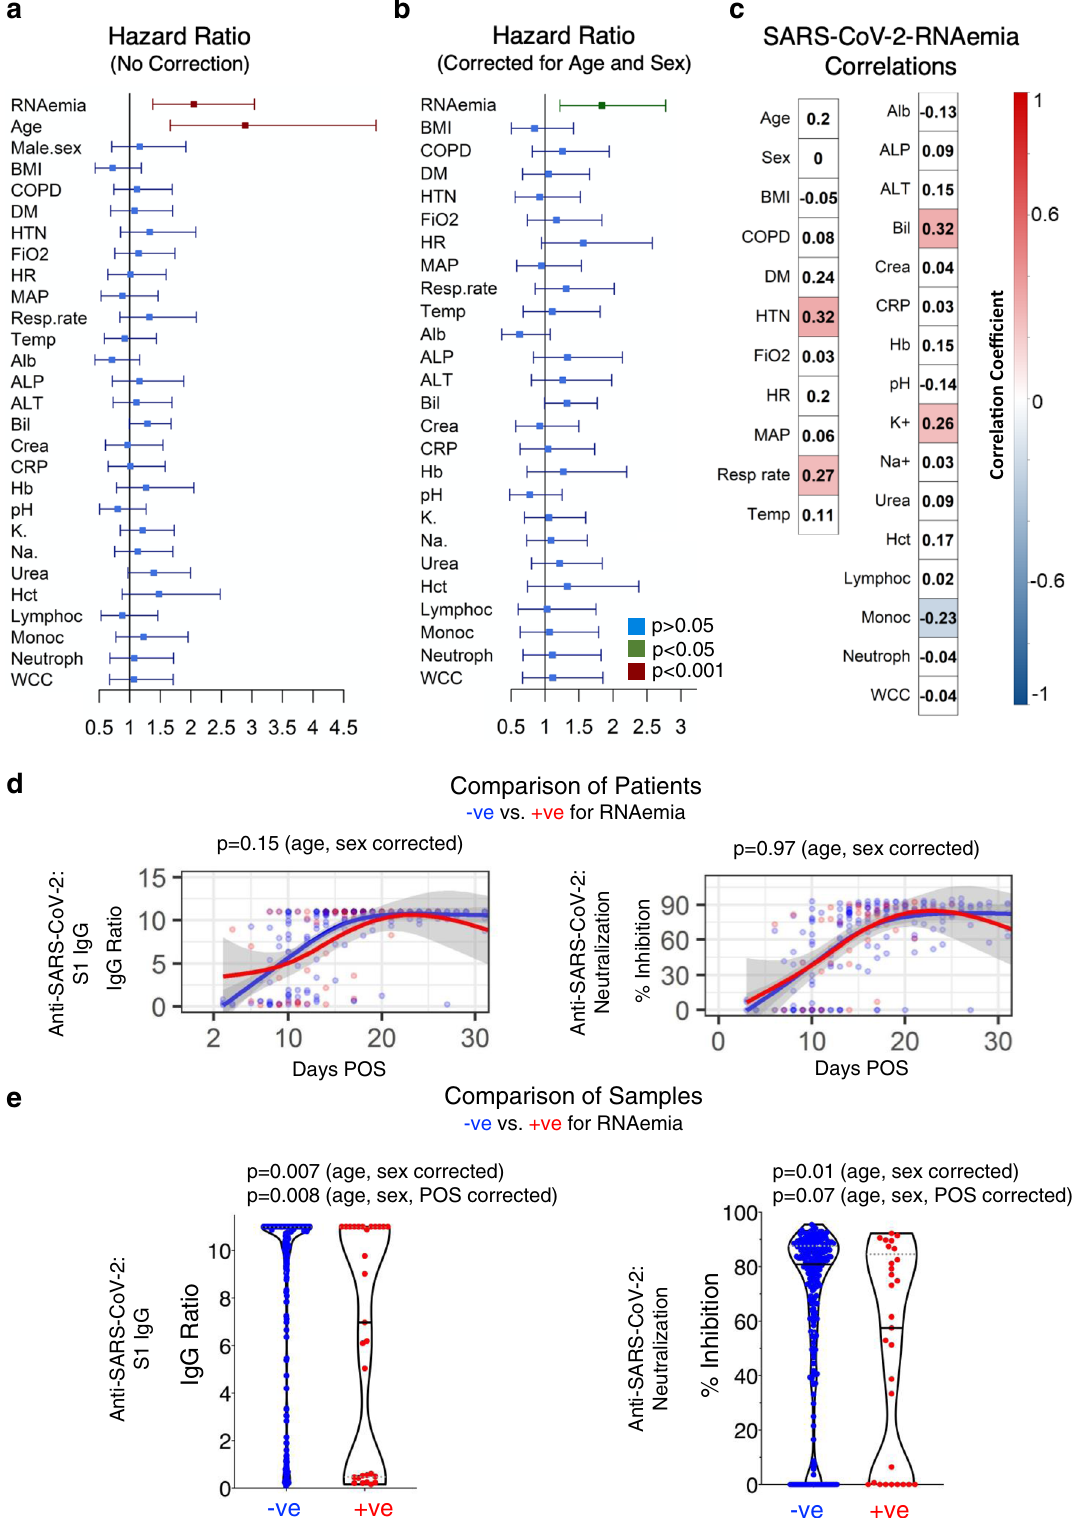
predicting mortality. When binary combinations were analyzed, two signatures emerged with comparable classi fi cation perfor- mance: “ Age, RNAemia ” and “ Age, PTX3 ” (Supplementary Table 6). Although the triplet combination of age, FiO 2 , and RNAemia achieved a ROC of ~86% with a sensitivity of 72.22% and a speci fi city of 88.33% (Supplementary Table 6), the gain in